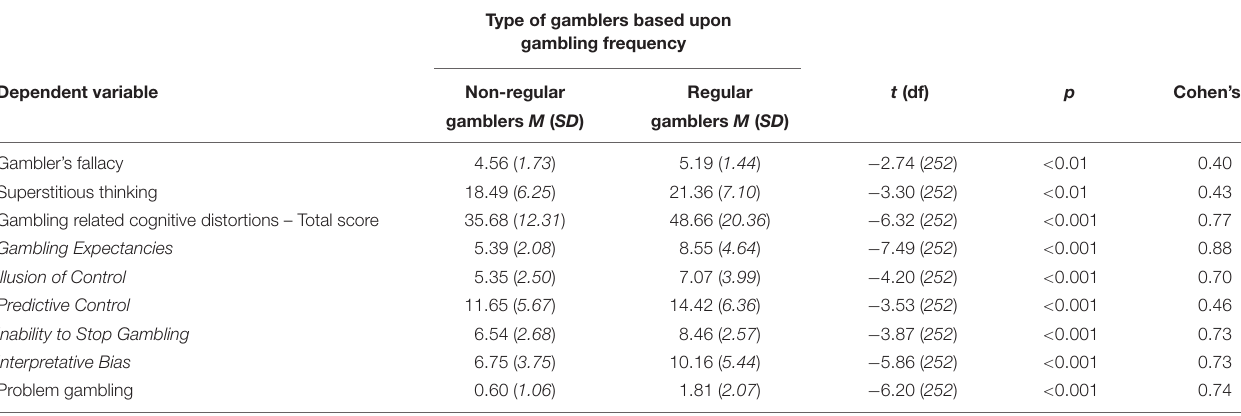
TABLE 1 | Descriptive statistics for gambler’s fallacy, superstitious thinking, gambling-related cognitive distortions – the GRCS total score and the subscale scores – and problem gambling for non-regular gamblers ( n = 86) and Regular gamblers ( n =